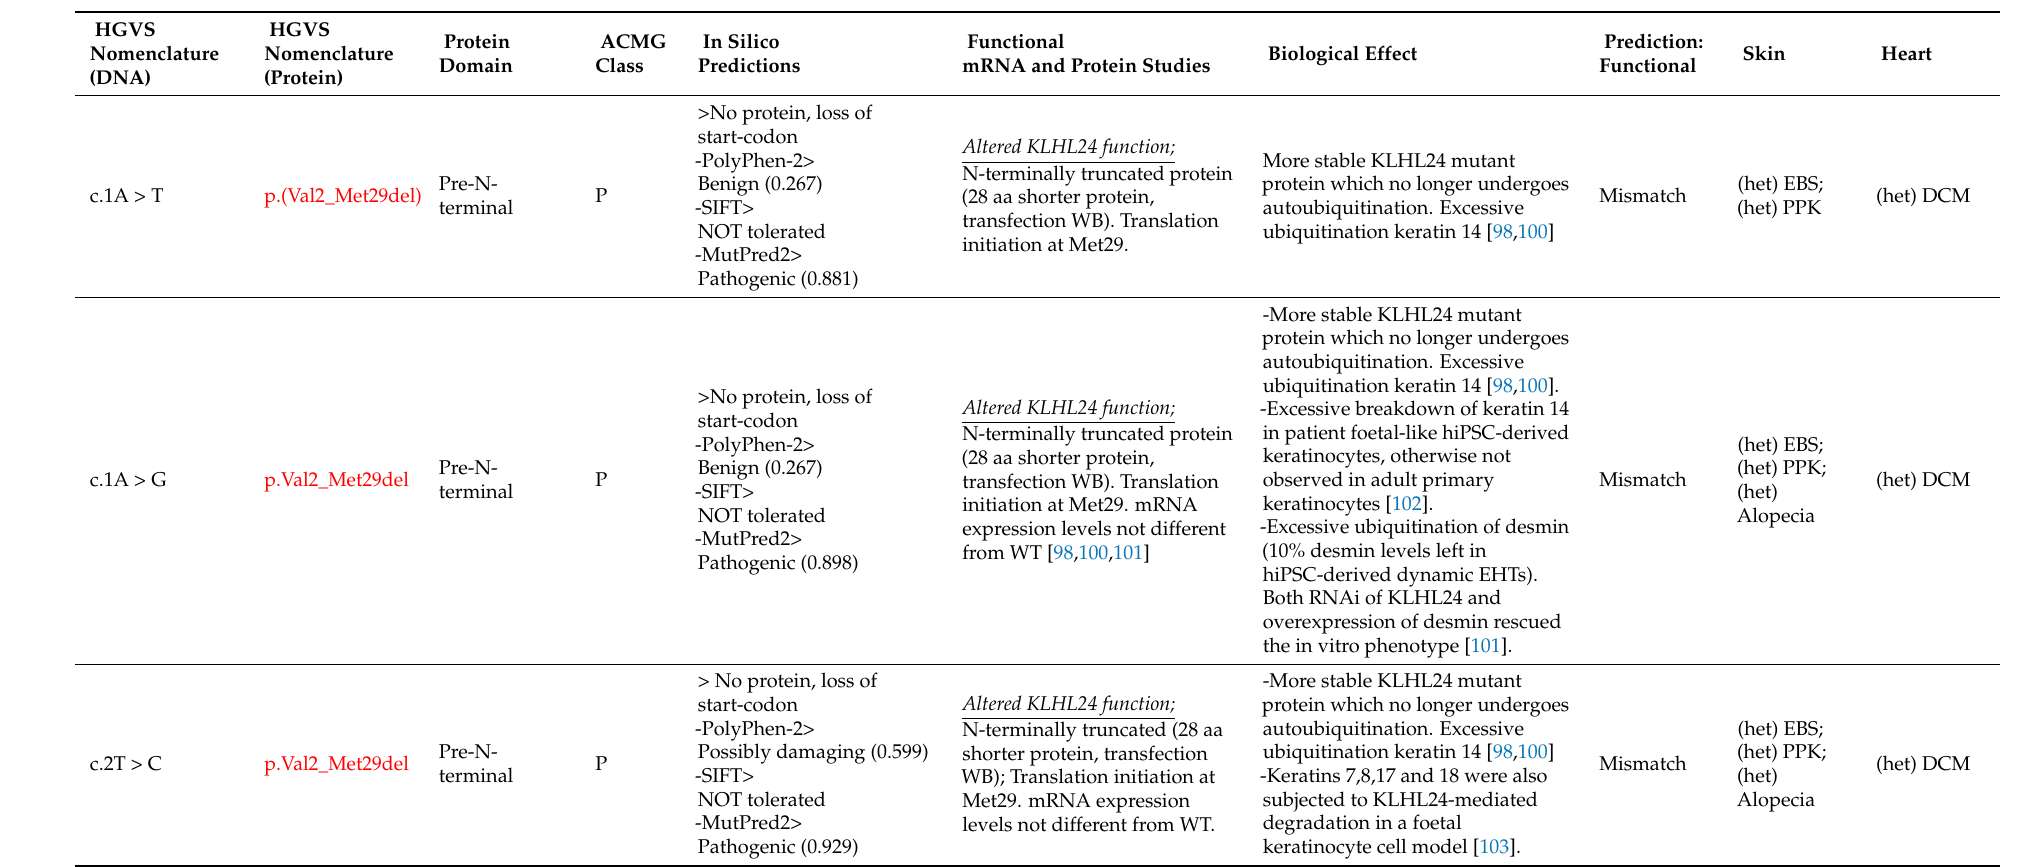
Table 4. Functionally analysed KLHL24